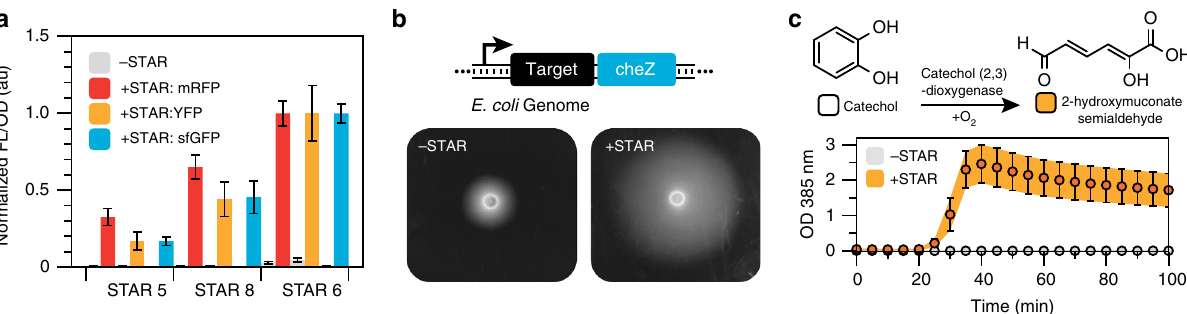
Fig. 3 STARs control gene expression tightly in diverse contexts. a STARs function in the context of sequence diverse fl uorescent reporter genes. Fluorescence characterization was performed on E. coli cells transformed separately with plasmids encoding three target RNAs controlling sfGFP, YFP or mRFP in the absence (-STAR) and presence (+STAR) of plasmids encoding cognate STARs. Measurements were normalized to 1 for the fl uorescence value of STAR variant 6 in the +STAR condition for each fl uorescent protein. Fluorescence characterization was performed by bulk fl uorescence measurements (measured in units of fl uorescence [FL]/optical density [OD] at 600 nm). b STARs function in the genome to control endogenous E. coli genes. Schematic of STAR regulated cheZ construct integrated into E. coli BW25113 Δ c heZ . Photographs of semi-solid agar motility assays in the absence (left panel, -STAR) and presence (right panel, +STAR) of a plasmid encoding the cognate STAR. Motility is indicated by the formation of halos around the inoculation site in the center of the photographs. c STARs function in cell-free transcription-translation (TX-TL) reactions to tightly control enzyme expression. Schematic of the catechol (2,3)-dioxygenase catalyzed reaction that converts colorless catechol into a yellow-colored 2-hydroxymuconate semialdehyde. Spectral characterization of observed yellow color (measured in units of OD at 385 nm) of STAR controlled catechol (2,3)-dioxygenase expression in TX-TL reactions supplemented with catechol in the absence (-STAR) and presence (+STAR) of a plasmid encoding cognate STAR. Data in a , c represent mean values and error bars represent s.d. of n = 9 biological replicates, and b is a representative photograph of n = 1 biological replicates with repeats shown